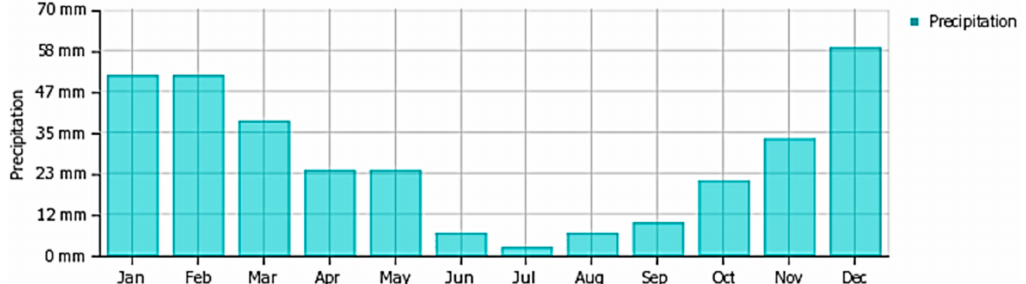
Figure 10. The mean monthly Relative Humidity of North-Cyprus